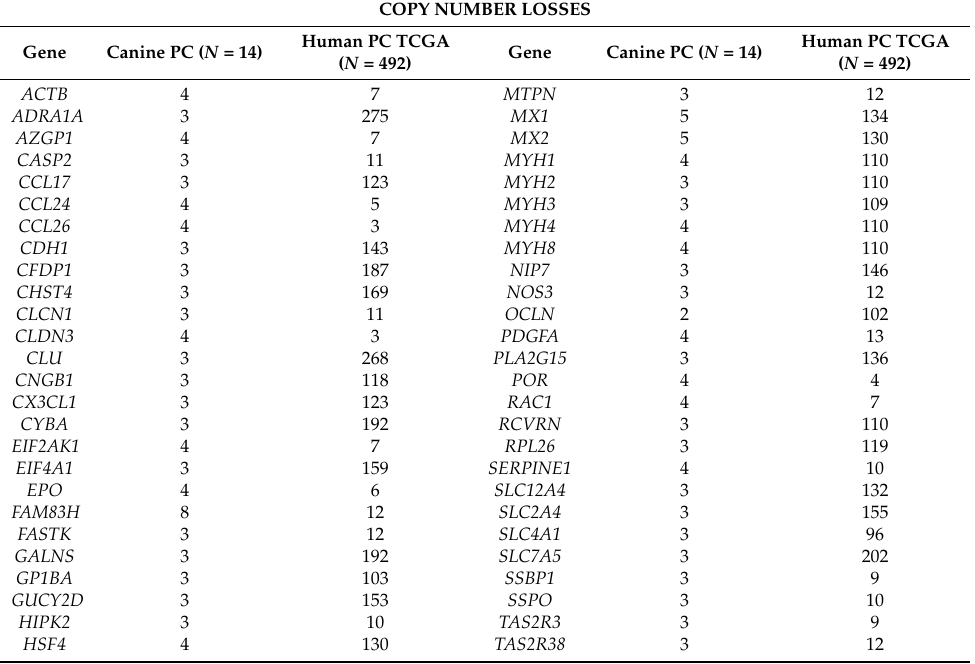
Figure 2. ( A ) Graphic representation of the canonical pathway called the molecular mechanism of cancer. Two cancer-related molecular interaction networks are indicated: ( B ) network 2, and ( C ) network 6, both associated with cell death and survival, organismal injury and abnormalities. Genes involved in gains, and losses are depicted in red and green colors, respectively. Images generated with the Ingenuity Pathway Analysis (IPA) software. Table 1. List of Genes Altered by CNAs in More than 20% of Our PC Cases ( N = 14), and in The Cancer Genome Atlas (TCGA) Dataset ( N =